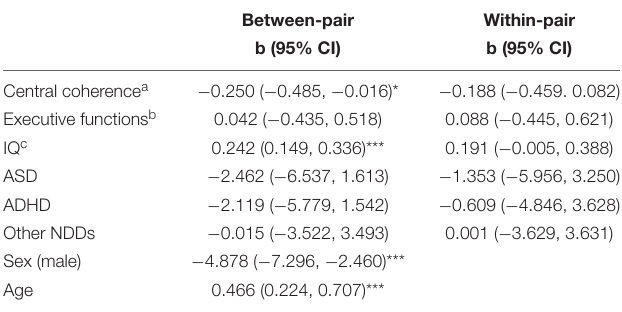
TABLE 4 | Results from the linear regressions with central coherence, executive function and IQ as predictors of Theory of Mind as measured with the Reading the Mind in the Eyes Test, also adjusting for diagnoses, sex and